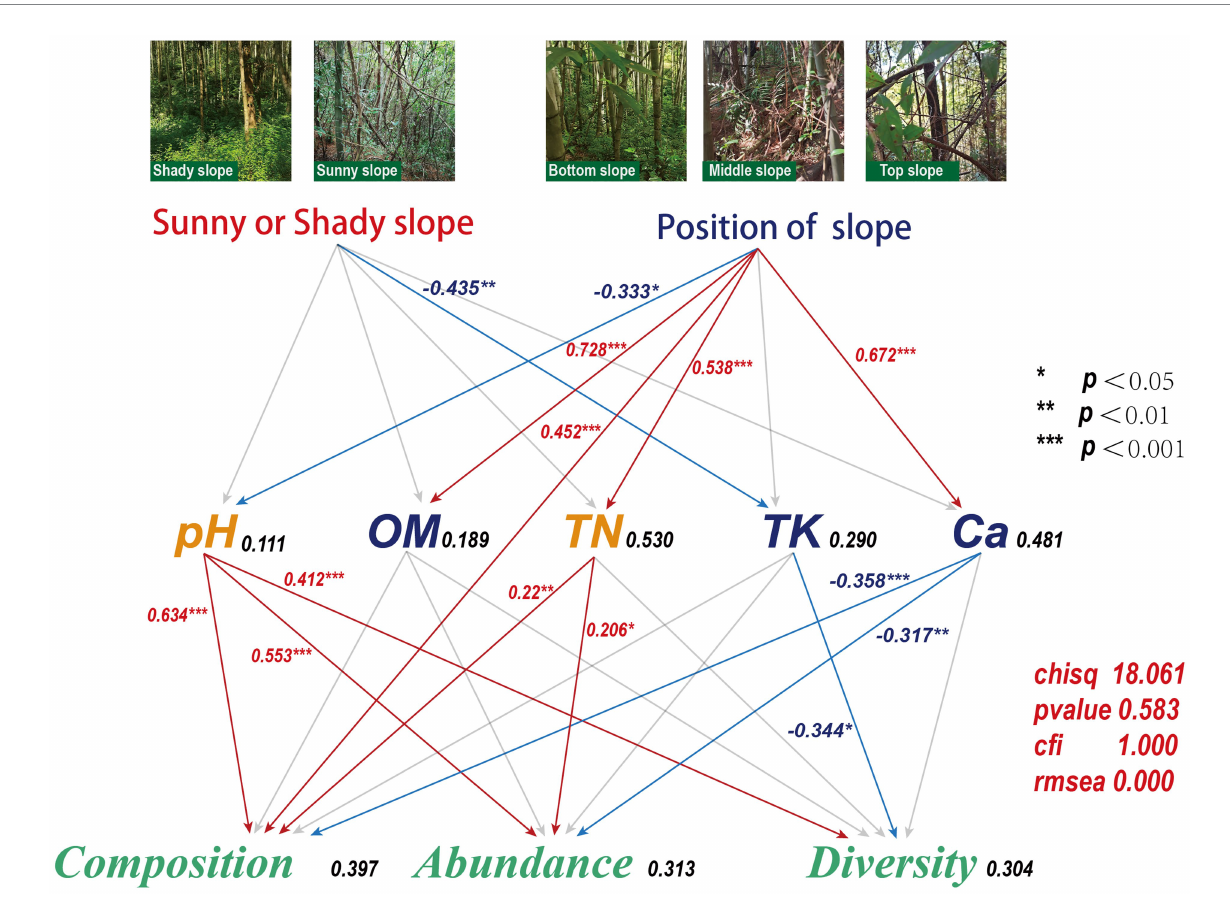
FIGURE 9 A structural equation model for the relationship between soil properties and microbial community composition, abundance, and diversity as influenced by slope direction and slope position. The number in the right of each of the soil or microbial parameter is the squared-multiple correlation, and the number on each line between these parameters is the standardized regression-weight (*: significant at p < 0.05; **: significant at p < 0.01; ***: significant at p < 0.001). Red solid lines indicate that the standardized regression weights are negative, blue solid lines indicate that the standardized regression weights are positive, and gray dashed lines indicate that the standardized regression weights are not significant ( p ≥ 0.05) and thus their statistics are not